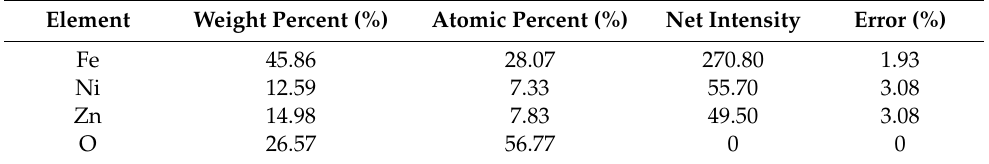
0.5 Zn 0.5 Fe 2 O 4